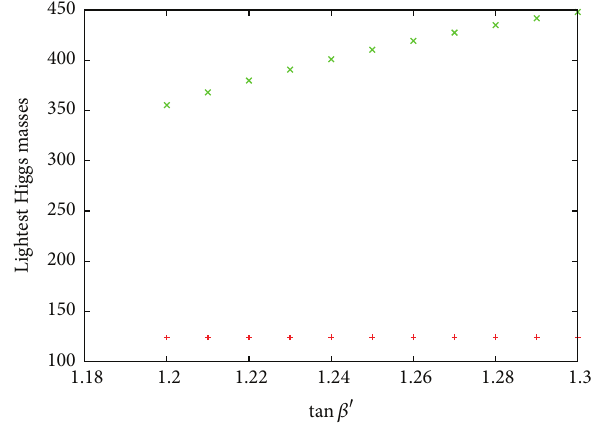
Figure 11: Simple plot created with a shell script and gnuplot showing the two lightest scalar masses as function of tan 𝛽 󸀠